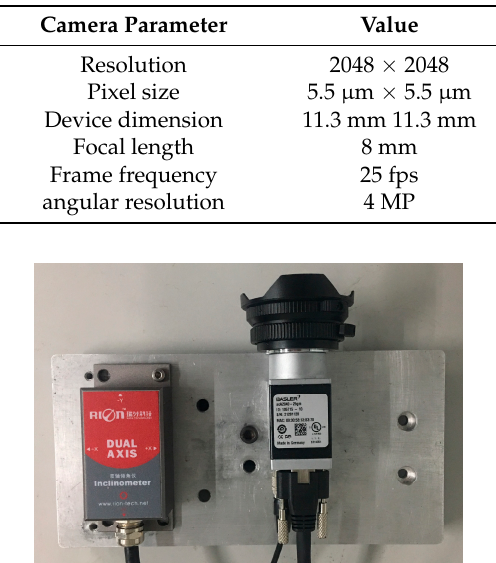
Figure 7. The photoelectric measurement system (System 2) by the Basler acA2040-25gm camera and the SCA126T inclinometer.